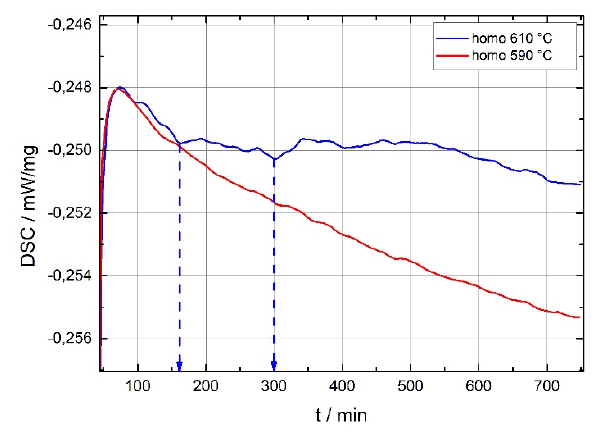
Figure 6. DSC measurement of homogenization annealing of EN AW 8006 alloy at 590 ◦ C and 610 ◦ C.